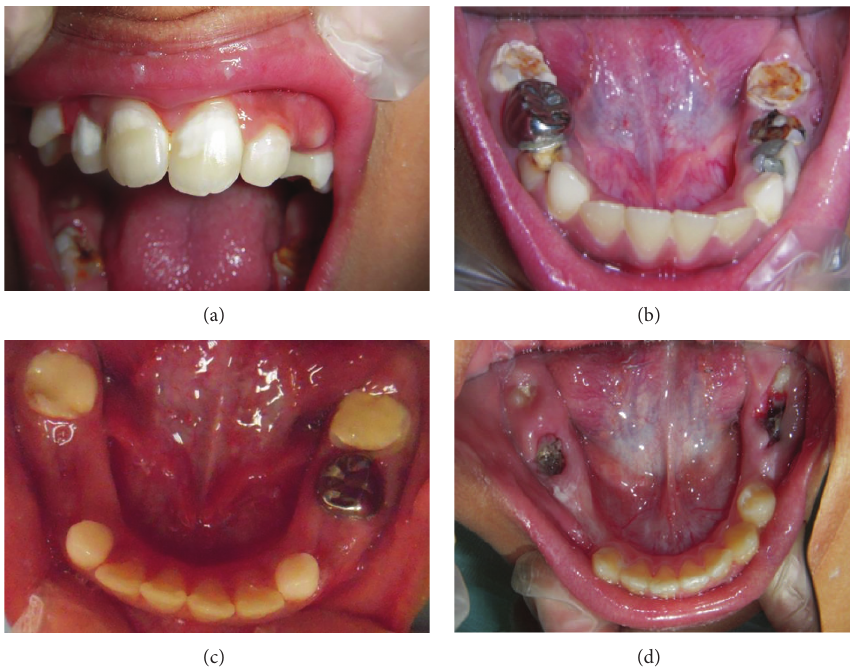
Figure 1: Diagnostic criteria of molar incisor hypomineralization. (a) Demarcate opacities (incisors). (b) Posteruptive breakdown (molars). (c) Atypical restorations (molars). (d) Extracted